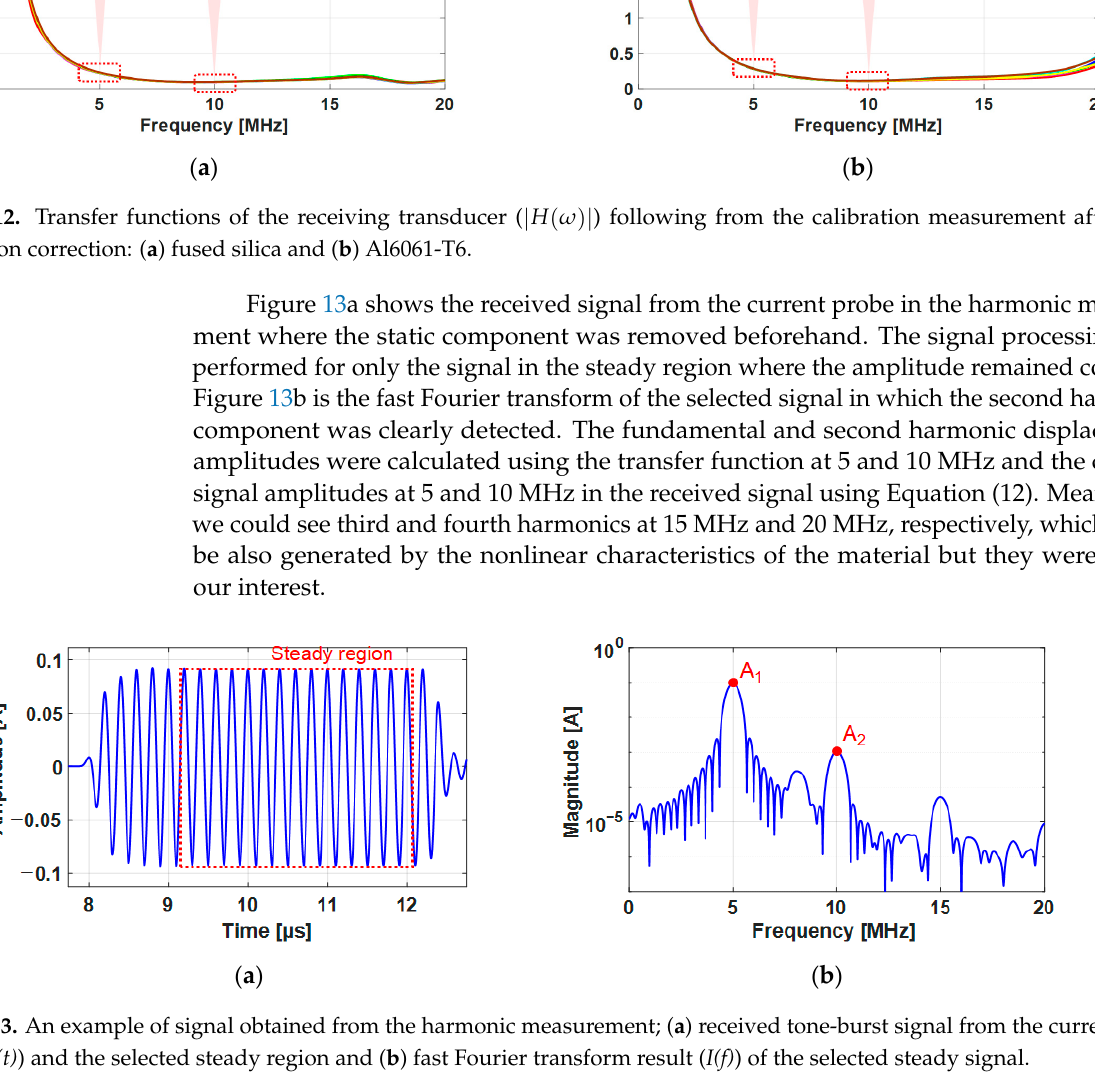
Figure 13. An example of signal obtained from the harmonic measurement; ( a ) received tone-burst signal from the current probe ( I(t) ) and the selected steady region and ( b ) fast Fourier transform result ( I(f) ) of the selected steady